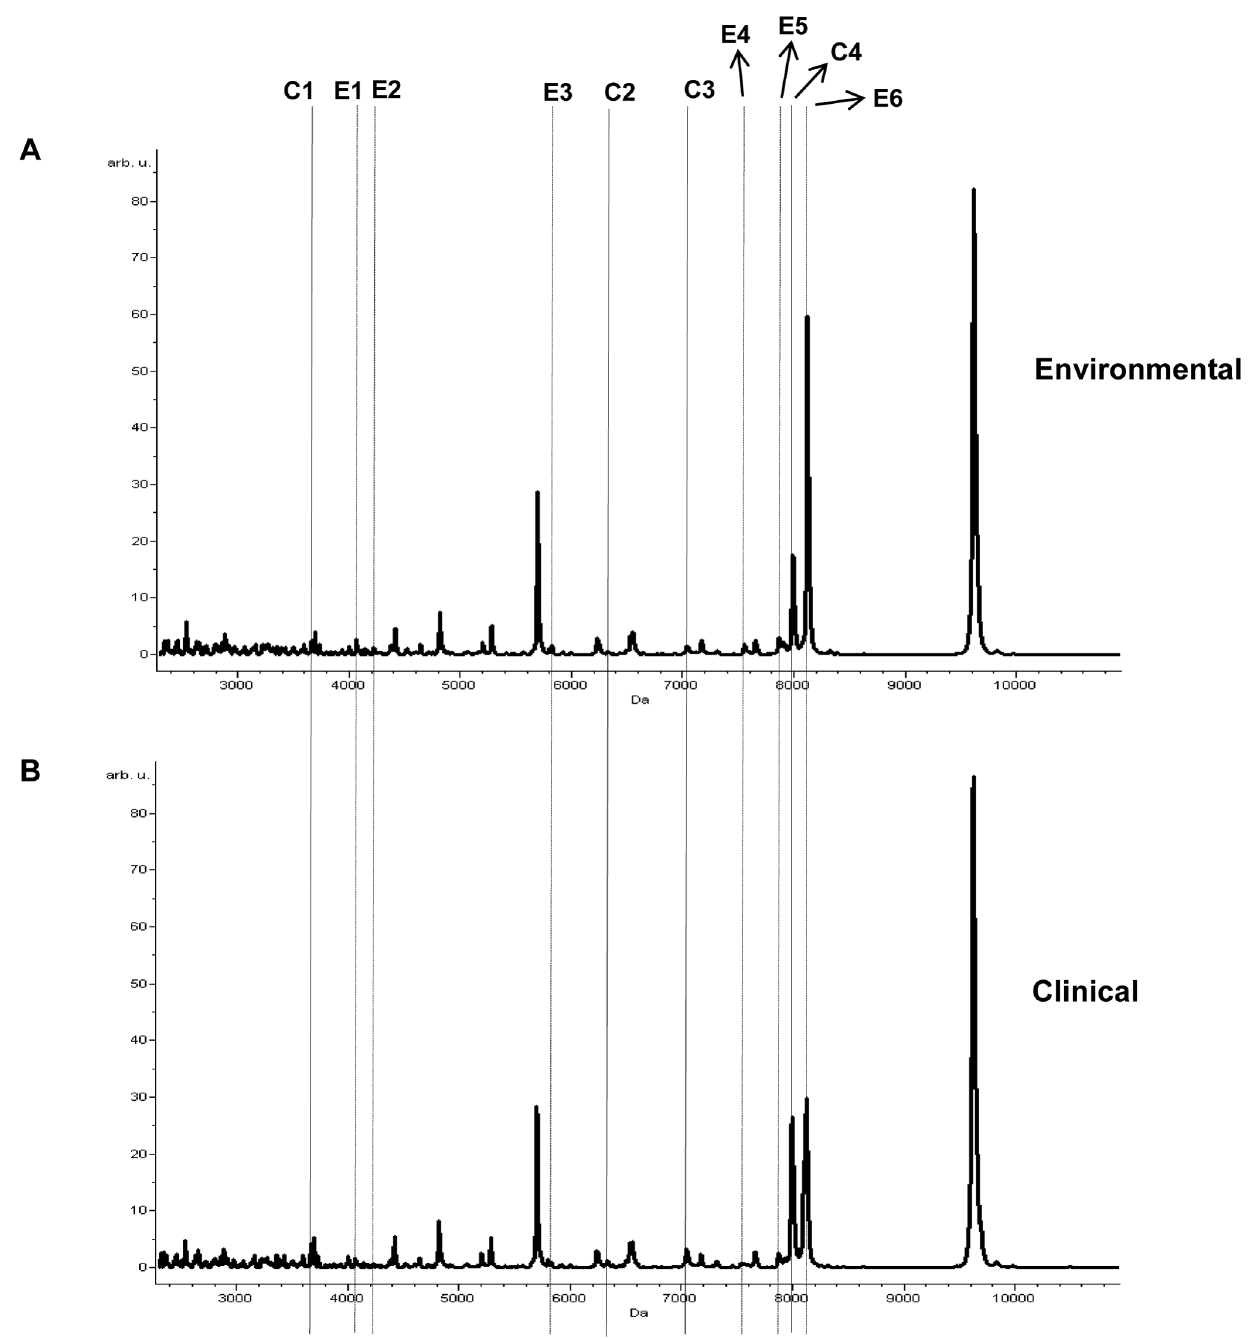
Figure 3. Potential source-identifying biomarker ions obtained from ClinProTools analysis. An average environmental spectrum of E10- E390 strains ( A ) had a very similar pattern as in a clinical set of K96243-NF154/37 ( B ) but peak intensity was different. The vertical dashed lines, E1-E6, indicated as environmental-identifying biomarker ions (EIBIs), consisting of m/z 4,056, 4,214, 5,814, 7,545, 7,895, and 8,112 whereas the vertical solid lines marked as C1-C4 displayed clinical-identifying biomarker ions (CIBIs), containing m/z 3,658, 6,322, 7,035, and